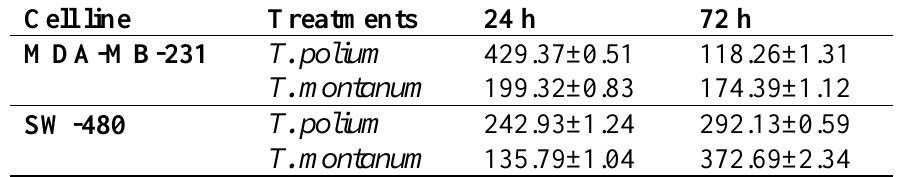
Table 1. Cytotoxic activity of T. polium and T. montanum , expressed as IC on MDA-MB-231 and SW-480 cell lines.